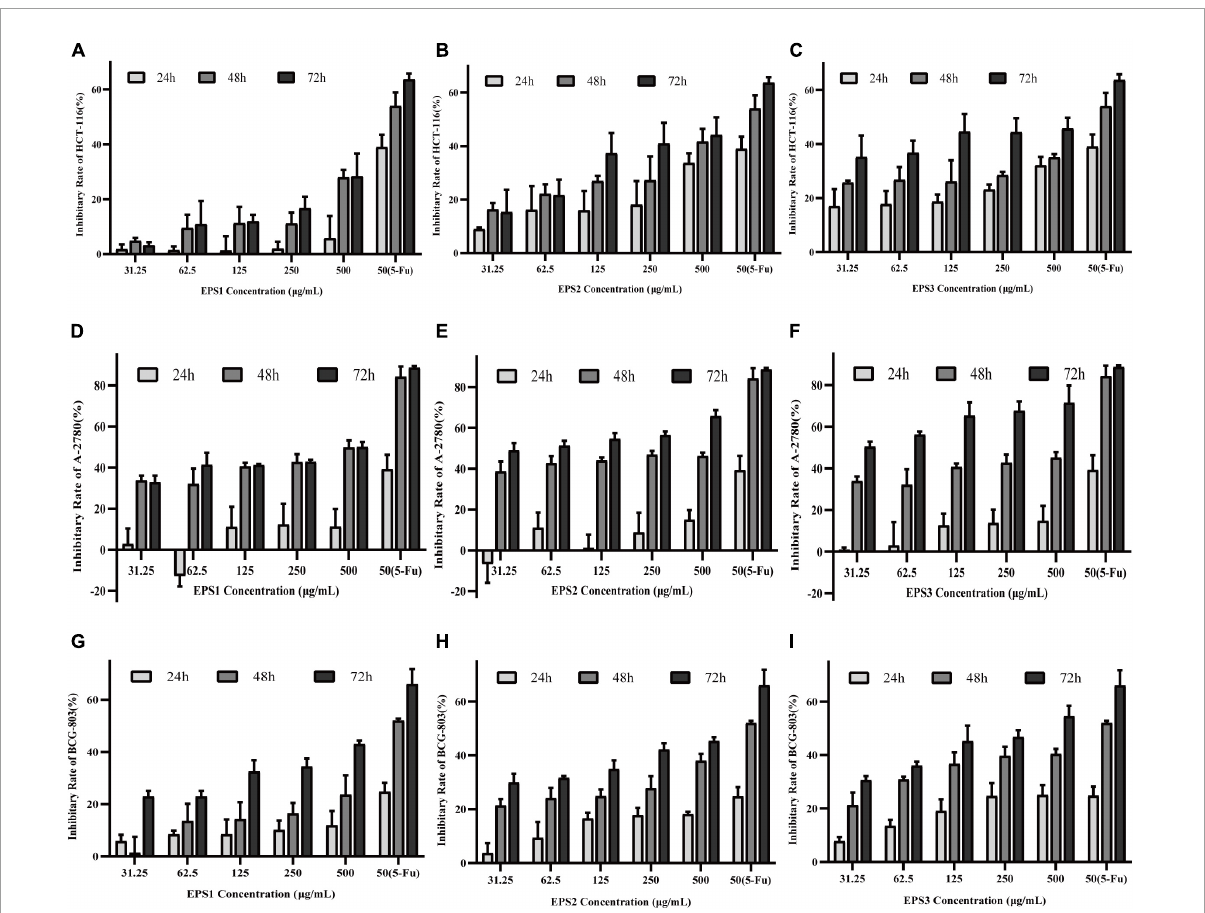
FIGURE11 The effects of the purified EPS1, EPS2, and EPS3 from L. pantheris TCP102 and 5-fluorouracil on human colon cancer (HCT-116), ovarian cancer (A-2780), and gastric cancer (BCG-803) cell lines. Effect of (A) Effect of EPS1, (B) EPS2, and (C) EPS3 on HCT-116 at 24, 48, and 72 h